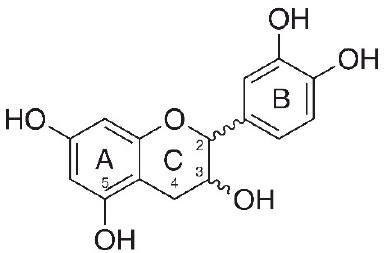
Figure 1. Chemical structure of catechin.